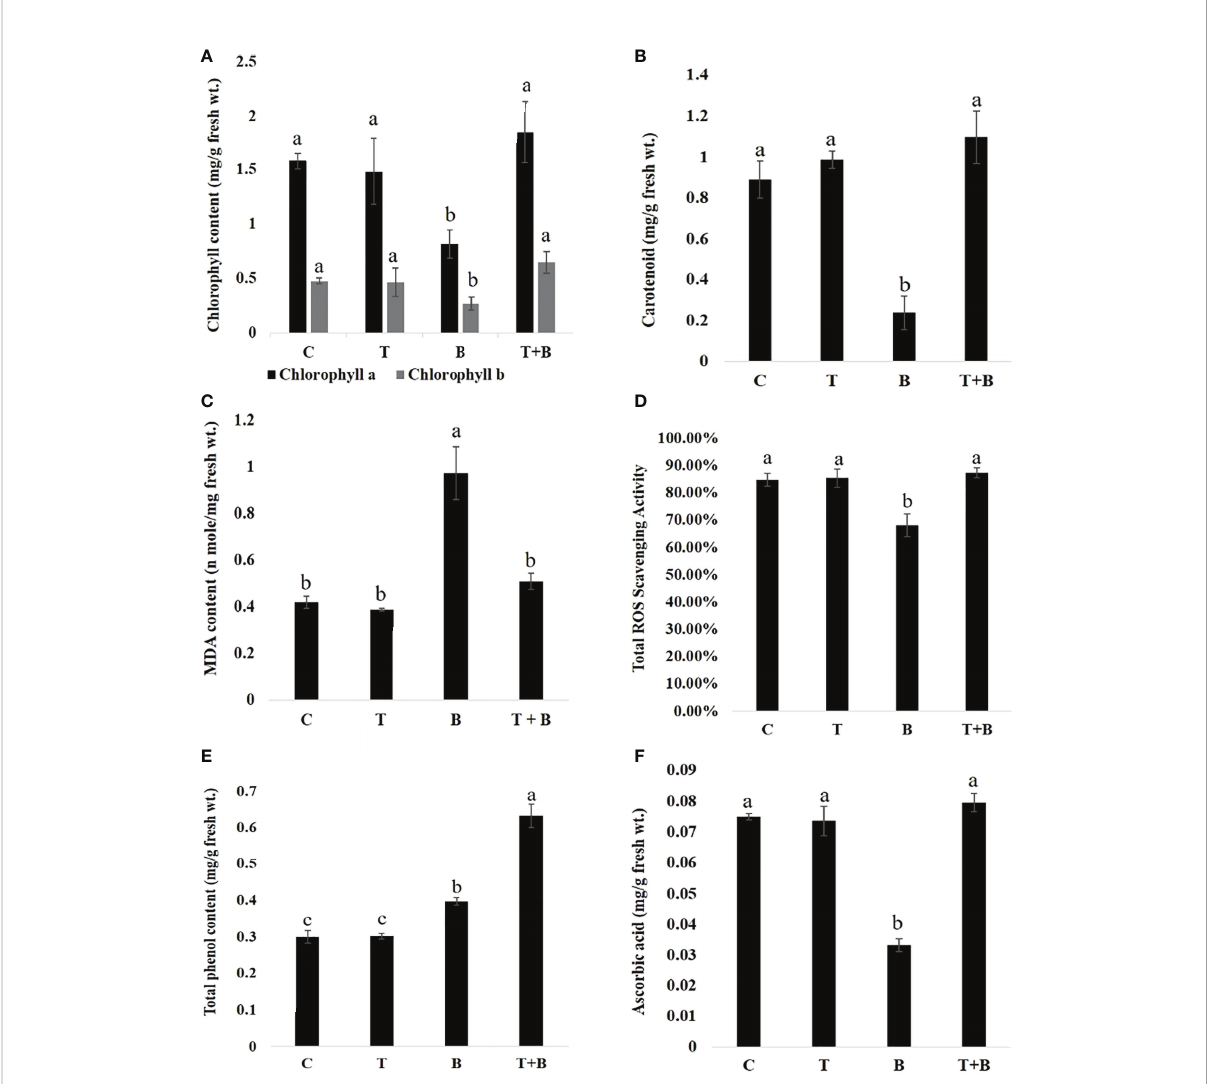
FIGURE 4 Biochemical changes in primed and non-primed wheat (G0) after challenging with Bipolaris sorokiniana HD 3069. (A) chlorophyll a and chlorophyll b, (B) carotenoid , (C) MDA content, (D) ROS scavenging activity, (E) Total phenol content and (F) Ascorbic acid of primed and non- primed wheat after challenging with Bipolaris . C = control, T = Trichoderma-primed , B = Non-primed wheat challenged with Bipolaris , T+B Trichoderma -primed and challenged with Bipolaris . Data in (A – F) are represented as mean ± SD (n = 21), and different alphabets indicate statistically signi fi cant difference at P<0.05 in Tukey's test. Results are representatives of three independent biological